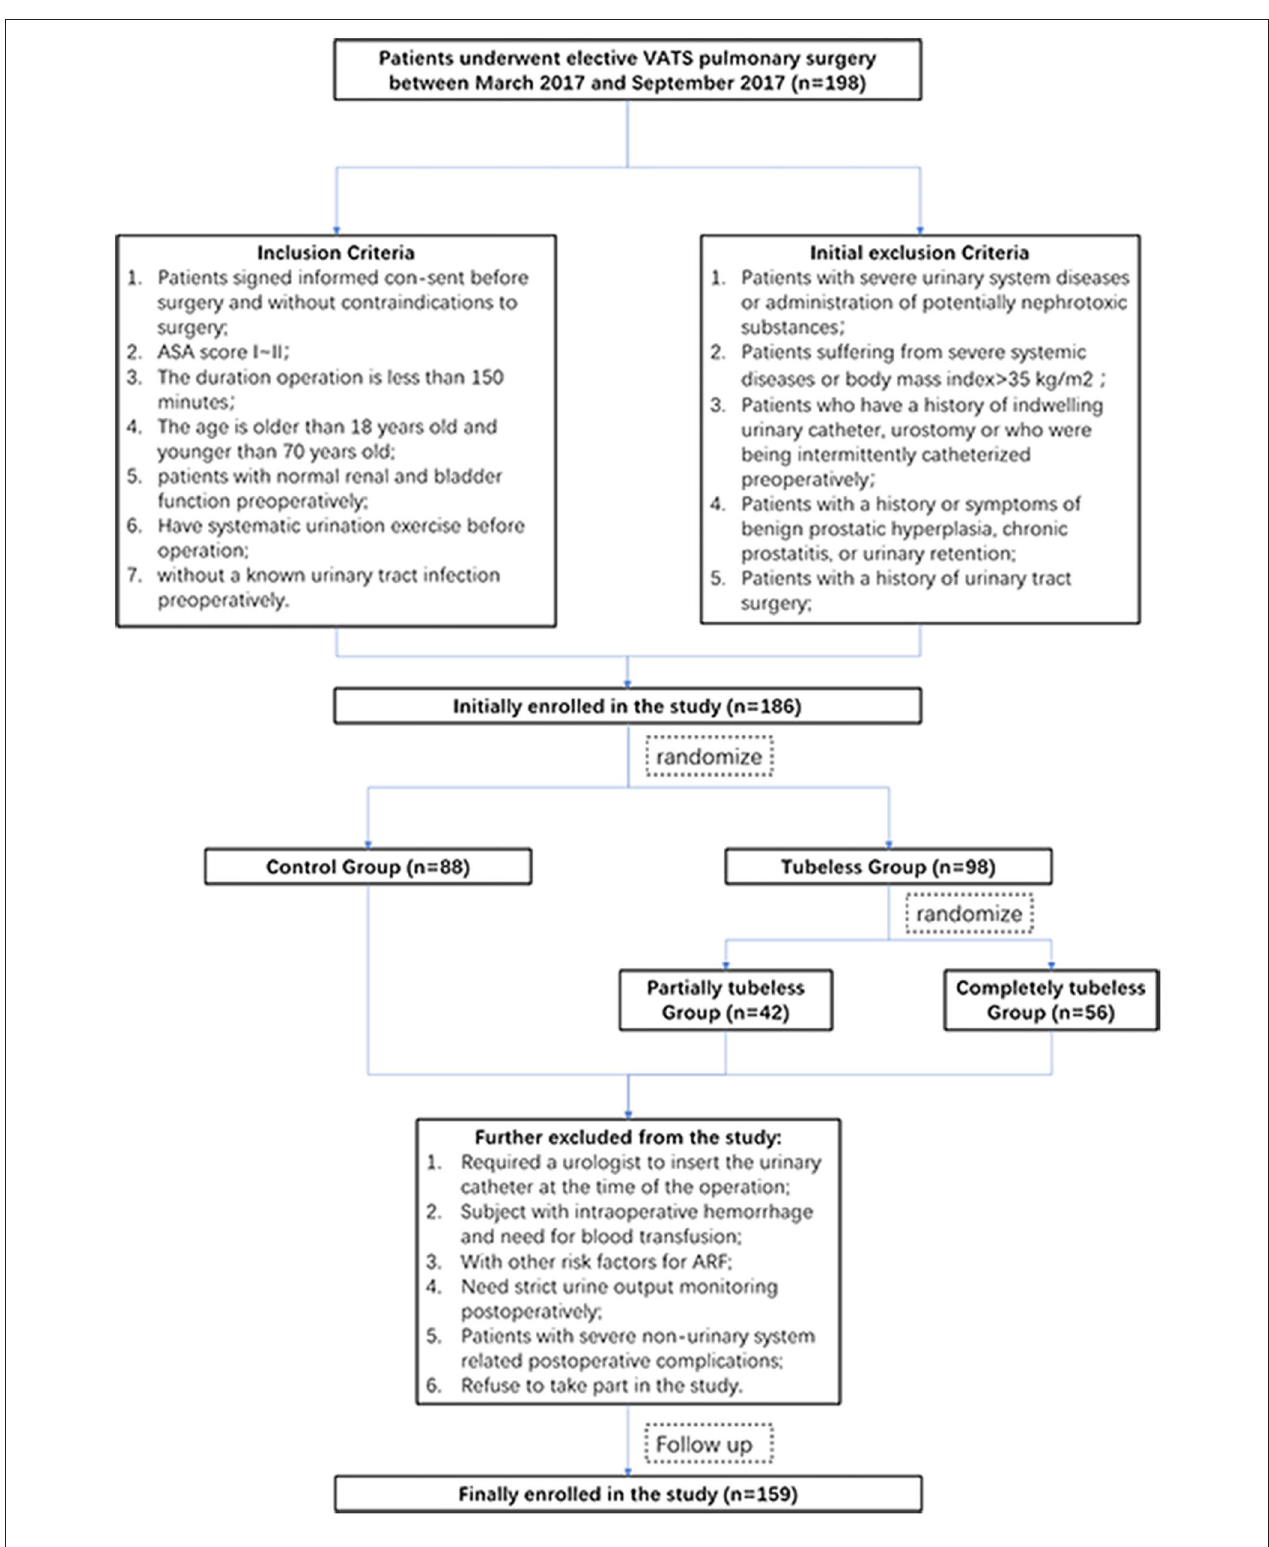
FIGURE 1 | Flowchart of the study.